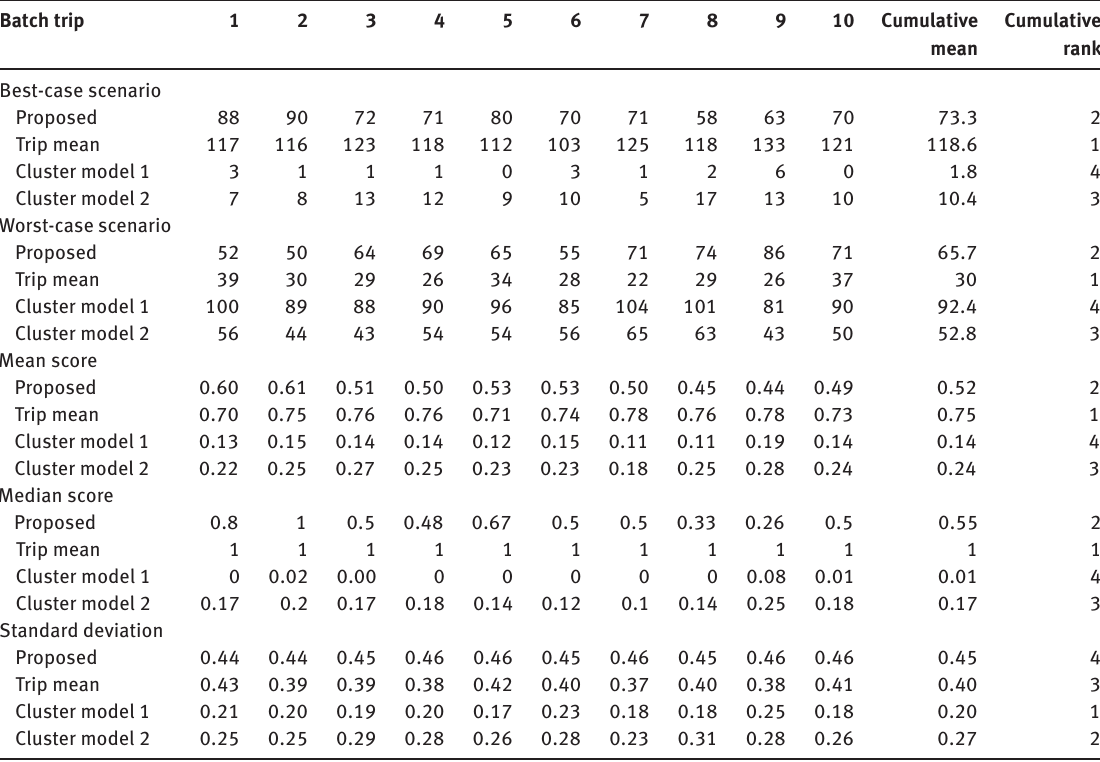
Table 4: Statistical Report on Trip Planning Models for 20% Tolerance.